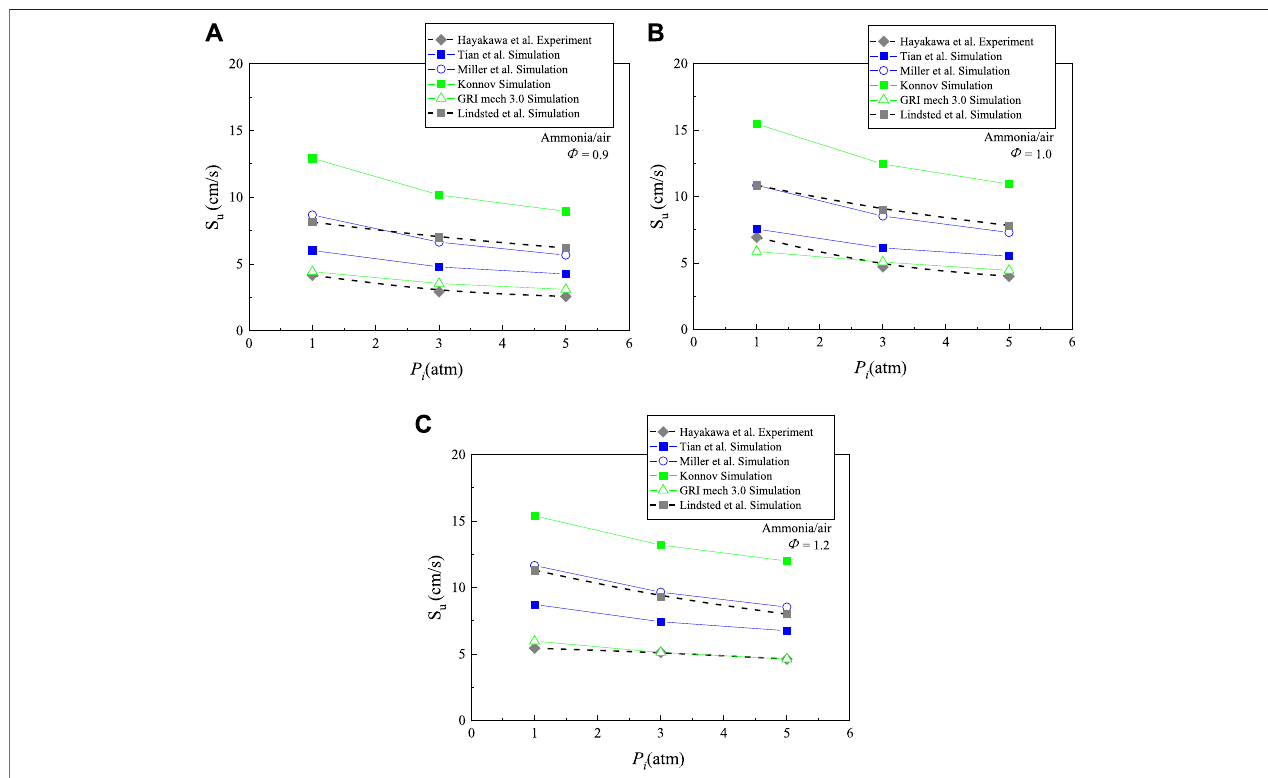
FIGURE 4 | Laminar burning velocity of NH 3 fl ame with a function of initial mixture pressure at φ (cid:1) 0.9, 1 and 1.2, replotted from (Hayakawa et al., 2015a).